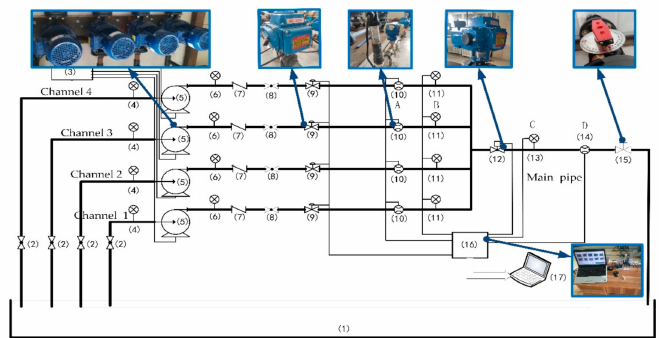
Figure 1. Research platform for multi-channel confluent water supply system: (1) water tank; (2) hand valve; (3) frequency converter; (4) vacuum meter; (5) centrifugal pump; (6) pressure gage; (7) check valve; (8) ball valve; (9) channel control valve; (10) channel flowmeter; (11) pressure transducer; (12) main control valve; (13) pressure transducer; (14) main flowmeter; (15) pipe load simulation valve; (16) DAQ card; (17) analysis